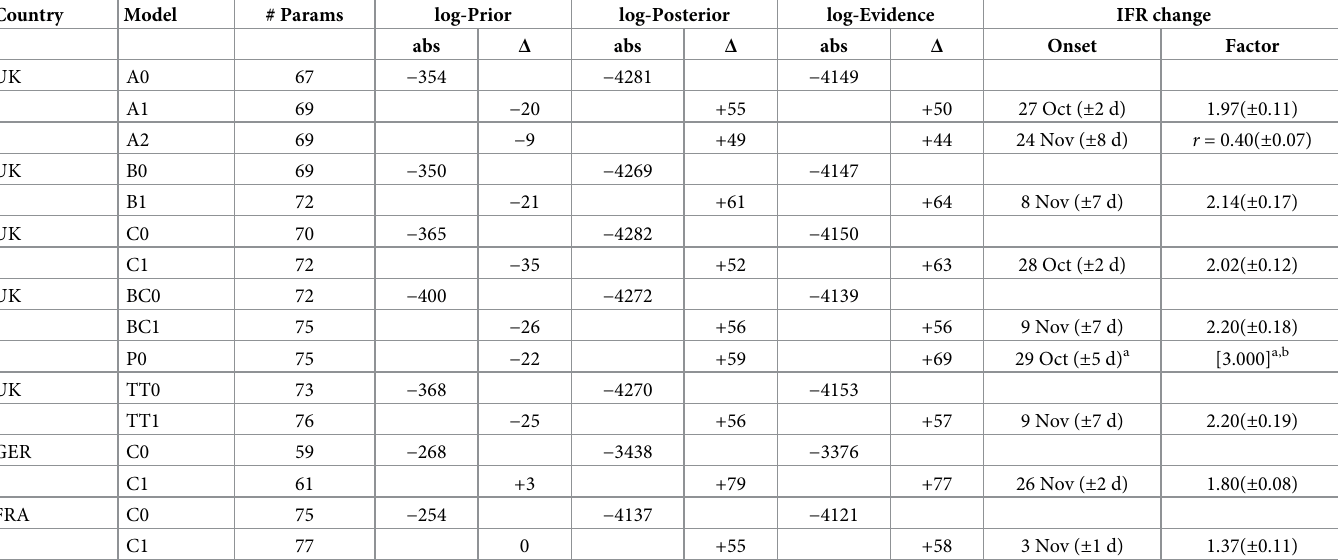
Table 2. Summary of MAP results.